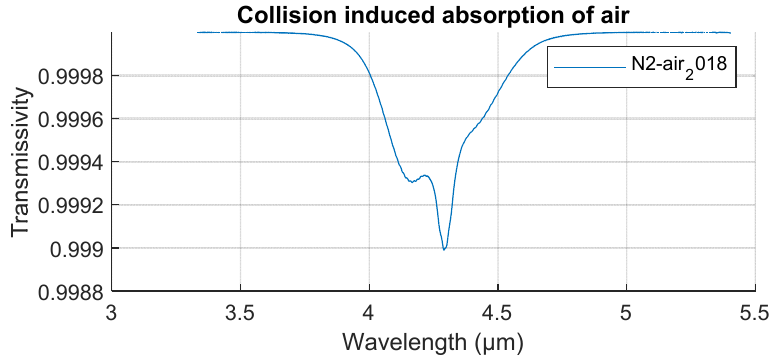
Figure 1. Collision-induced absorption of air. Line-by-line absorption data in Figure 1 was obtained from The HITRAN2016 molecular spectroscopic database [8] and converted to absorption coefficient spectrum A c ( λ ; p , pp , T ) using the MATLAB function Load Hitran by DeVore [26] for set individual gas component of a calculated number density. Within the nine molecular species presented in Table 2, a total of 25 isotopologs have been accounted for. An isotopolog is a variation of a molecule where at least one of its atoms are an isotope. Isotopologs of total molar concentrations of less than 0.01 ppm in dry air were omitted from the calculation. Abundance values were sourced from the HITRAN2016 database, whereas atomic masses of isotopes were obtained from Bievre et al. [27]. Absorption cross section of species i is calculated for multiple isotopologs indexed with j and weighted corresponding to isotopolog abundance a j .